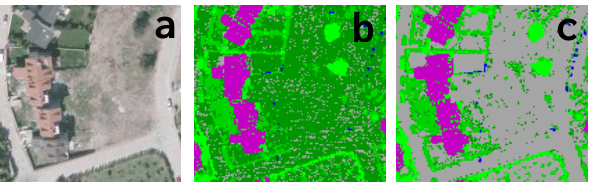
Figure 2. Ortho image of the selected pilot area 1, the classification results without (b) and with (c) parameter analyses for ground